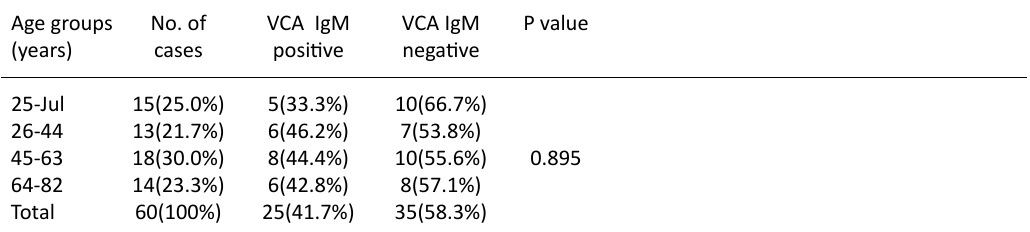
Table 5. Serological identification of (VCA IgM ) by age groups of female patients Age groups No. of